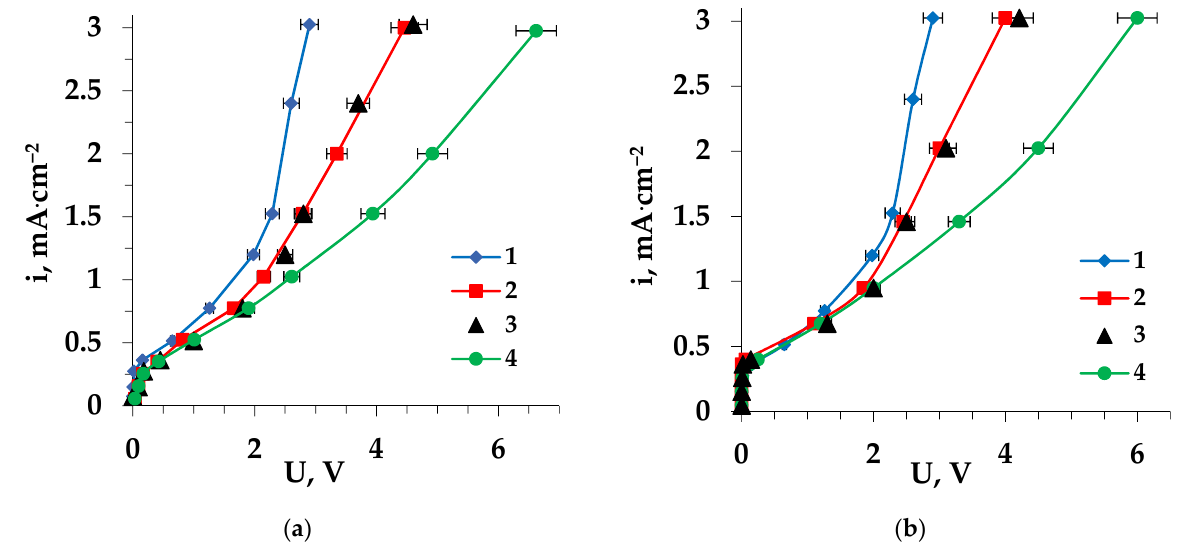
Figure 4. Current-voltage characteristics of the MA-41 anion-exchange membrane during the electrodialysis of Trp + NaCl ( a ), Pro + NaCl ( b ) solutions: 1—pristine membrane during the ED of NaCl solution, 2—pristine membrane, 3—electrochemically-regenerated membrane, 4—fouled membrane.